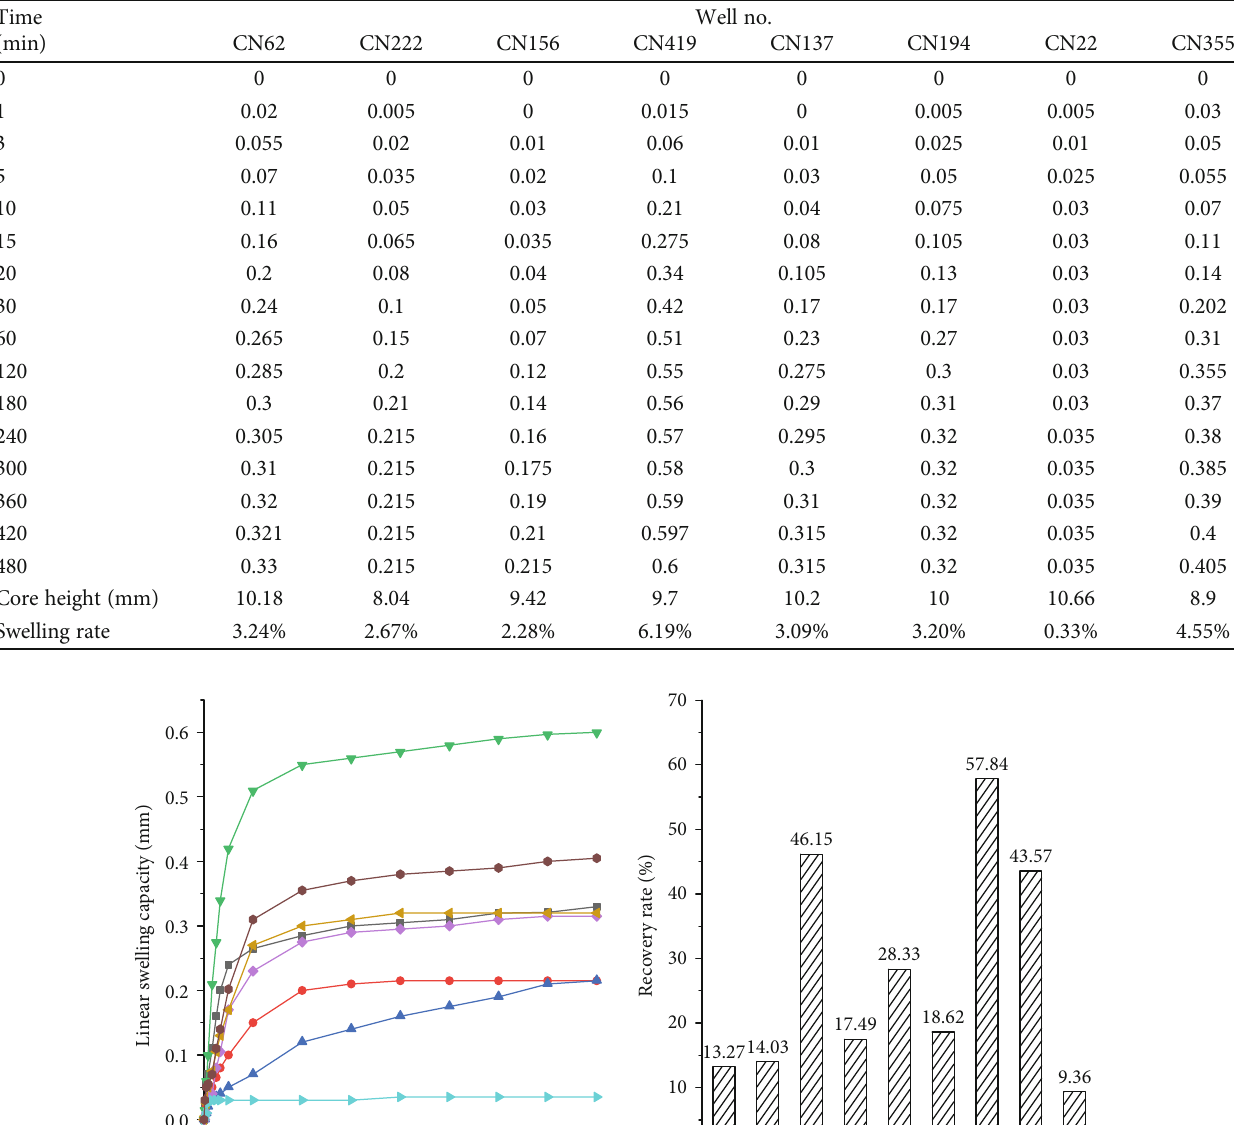
Table 4: Experimental data of hydration expansion.